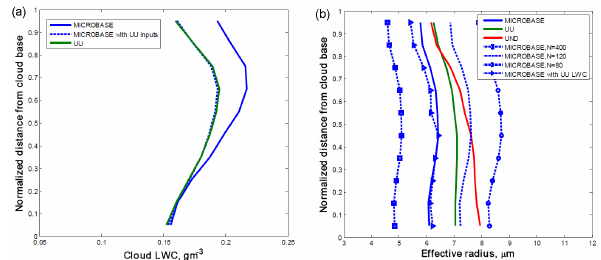
Fig. 12. Cloud LWC and r e retrievals as a function of normal- ized height from a suite of retrieval experiments. In (a) , the MI- CROBASE LWC algorithm is modified to use the UU input data and the experiment is based on non-raining non-mixed-phase cases at the SGP site from 1998 to 2006. In (b) , the MICROBASE r e algorithm is modified to use UU LWC retrievals and different droplet number concentrations and only non-raining non-mixed- phase low-level stratus cases are considered. Note that the standard MICROBASE algorithm uses N = 200cm − 1